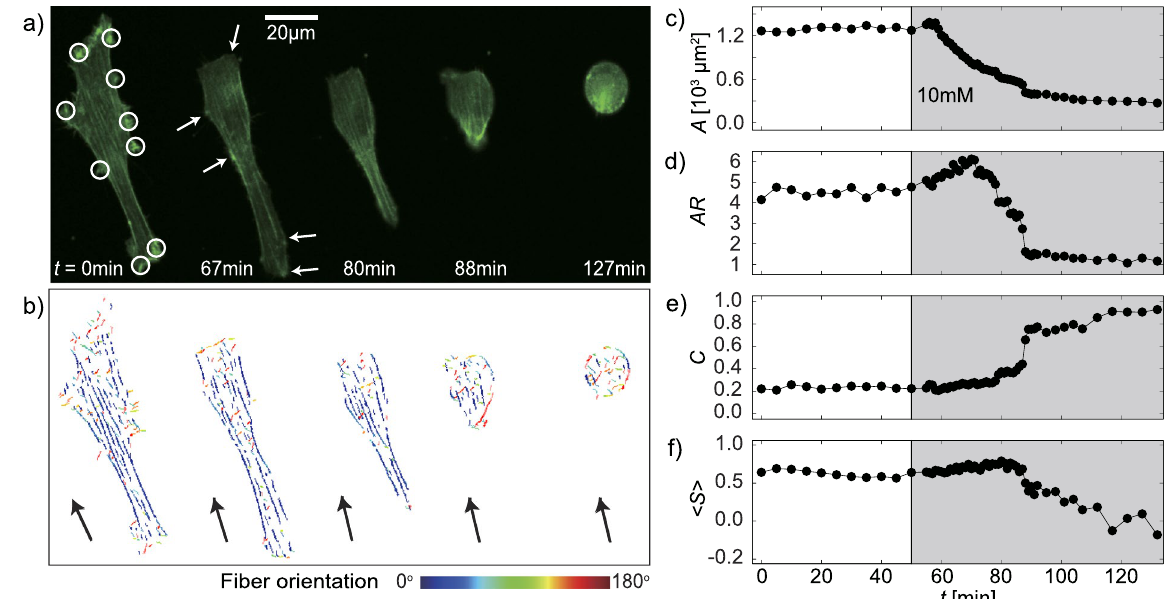
Figure 5. In situ mechano-response of C2C12. Dynamic response of C2C12 myoblasts upon the softening of β CD–Ad gel (2,2) from E ≈ 11 to 4 kPa, caused by the exchange to the medium containing 10 mM of β CD. ( a ) Snapshot images of a C2C12 cell from the live cell imaging (LifeAct-GFP). ( b ) Actin cytoskeletons extracted from the images. Changes in ( c ) projected cell area A , ( d ) aspect ratio AR , ( e ) circularity C , and ( f ) nematic order parameter of actin cytoskeleton < S > are plotted over time. The medium was exchanged at t = 50 min, and medium containing β CD was continuously supplied in the shaded time